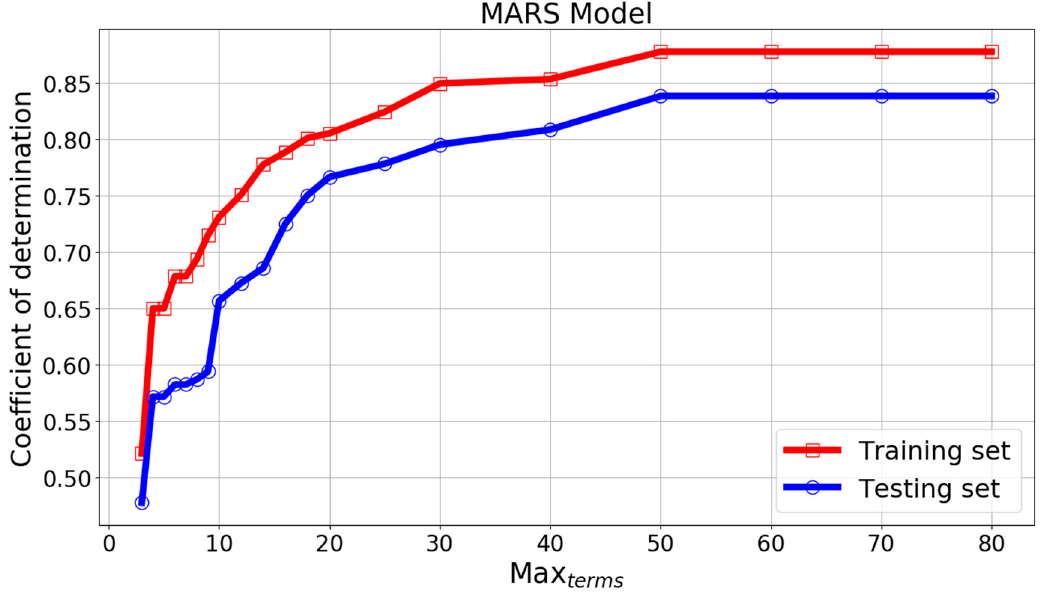
Figure 29. R 2 change curve of MARS model with parameter Max terms.